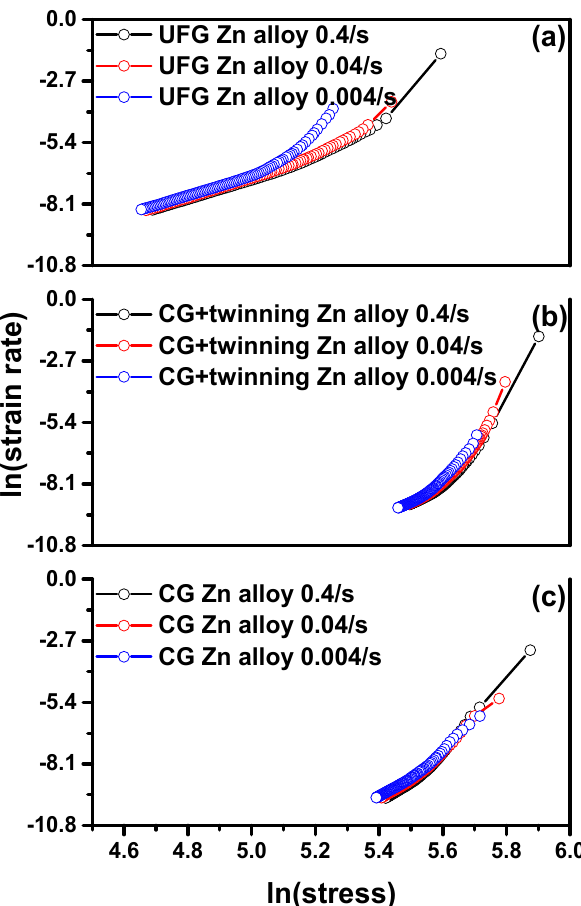
/ s ( a ), 0.04 / s ( b ) and 0.004 / s ( c ) with . ε / s, 0.04 / s and 0.004 / s. L of 0.4